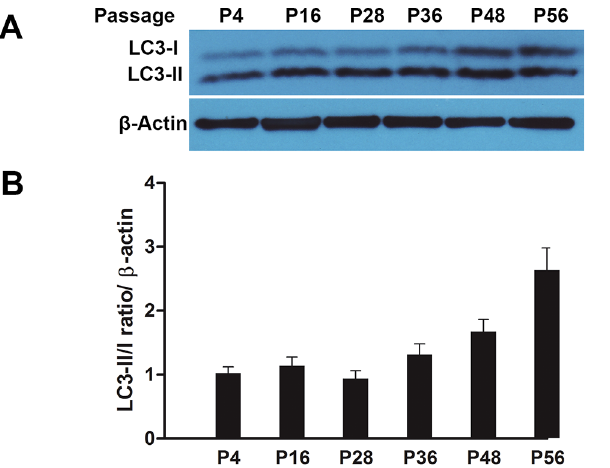
Fig 2. Immunoblotting-based comparison of levels of LC3-I and LC3-II in serially passaged human skin fibroblasts during aging in vitro . Cell samples were analyzed at six age points (P4, 16, 24, 36, 44 and 56) covering the whole replicative lifespan. (A) Immunoblot bands for LC3-I and LC3-II, and ß-actin as internal loading control. (B) Quantitative analysis of band intensity using ImageJ gel analysis software; data are presented as LC3-II/LC3-I ratio/